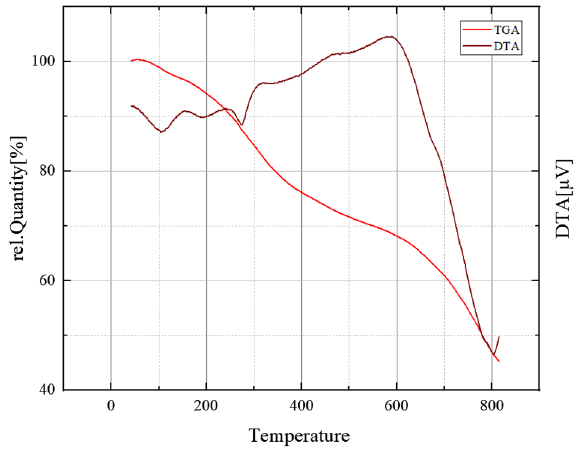
Figure 5. TGA/DTA curves of FNASiPPEA.